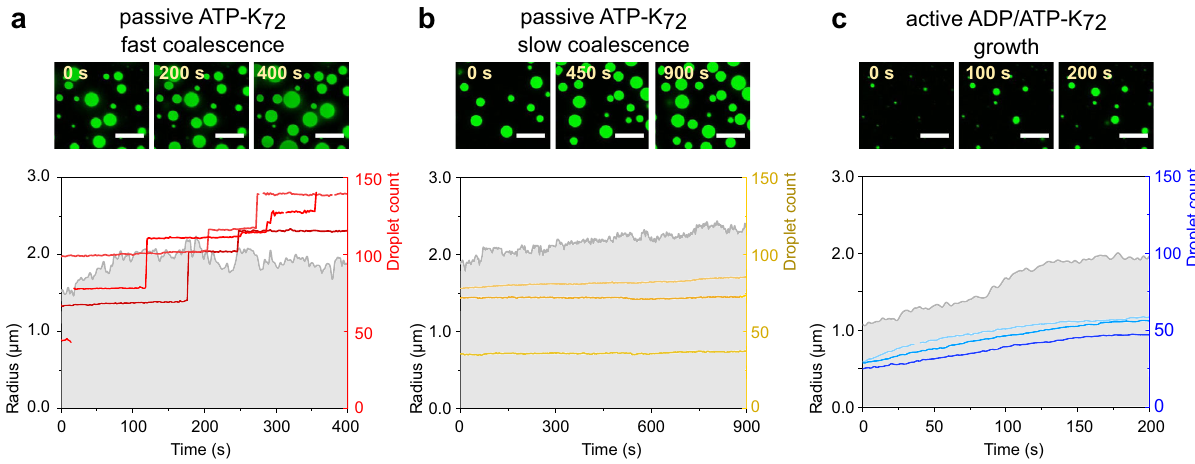
Fig. 3 Passive and active droplets in radius pro fi les. Bottom: a Passive coacervate droplets exhibit discrete increases in radius or ( b ) at lower volume fraction can remain stable for minutes. c The gradual increase in droplet radius over time is characteristic of active droplets, for which also the droplet count increases. All: left axes indicate droplet radius (in μ m) and right axes indicate droplet count. For visual clarity, only three exemplary traces were chosen out of each experiment. The output of the analysis containing all traces in ( a ) and ( b ) can be found in Supplementary Fig. 7. All traces of ( c ) are shown and discussed further in Fig. 5a. Top: scale bars are 10 μ m. Full microscopy frames can be found in Supplementary Fig. 8. From the confocal slices, we extract droplet radii to calculate the total coacervate volume and use the fi eld of view as a rectangular cuboid to calculate total